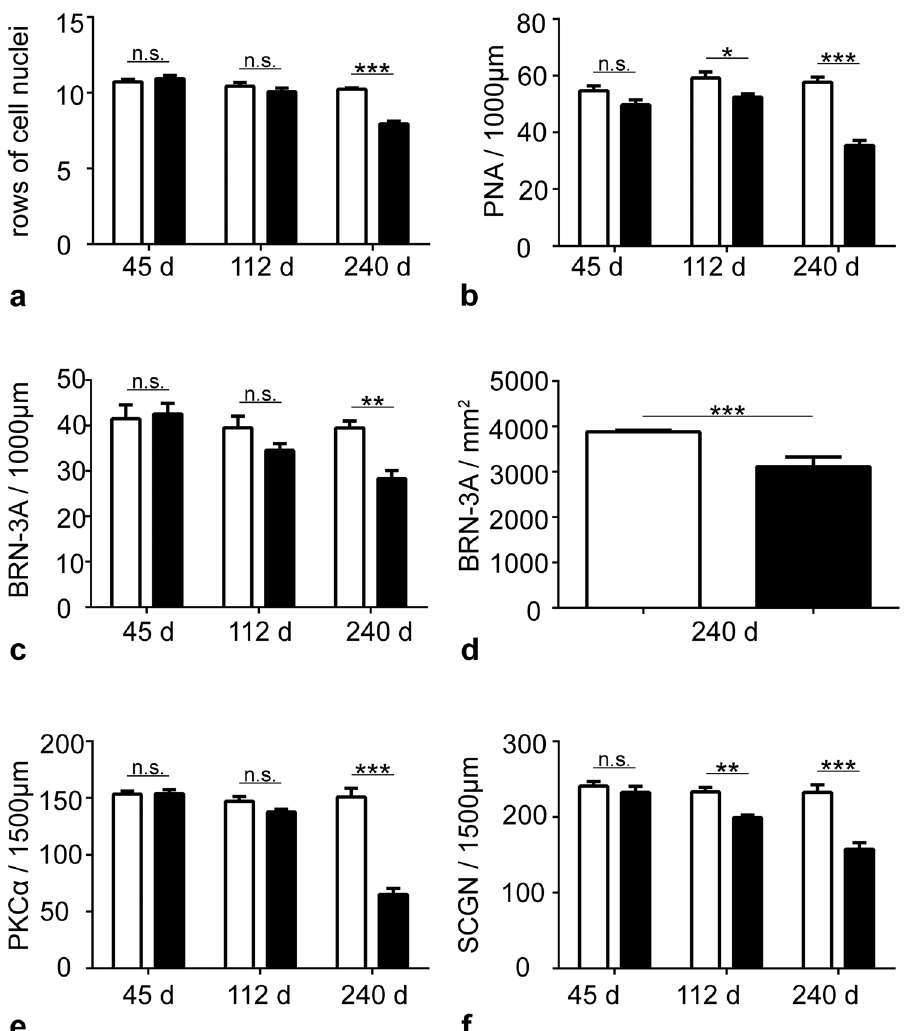
Figure 9. Degeneration of various retinal cell types in Ppt1 ko mice. The number of rows of photoreceptor nuclei ( a ) and the density of PNA-labeled cone photoreceptor cells ( b ), BRN-3A-positive retinal ganglion cells in retinal sections ( c ) or retinal flatmounts ( d ), PKC α -positive rod bipolar cells ( e ) and SCGN-positive cone bipolar cells ( f ) were determined in 45-, 112- and 240-day-old Ppt1 ko (filled bars) and wild-type mice (open bars). Each bar represents the mean value ± SEM of six animals. Statistical analyses of data were performed with the two-way ANOVA followed by a Bonferroni post-hoc test ( a–c,e,f ) or the Mann-Whitney U test ( d ). n.s.: not